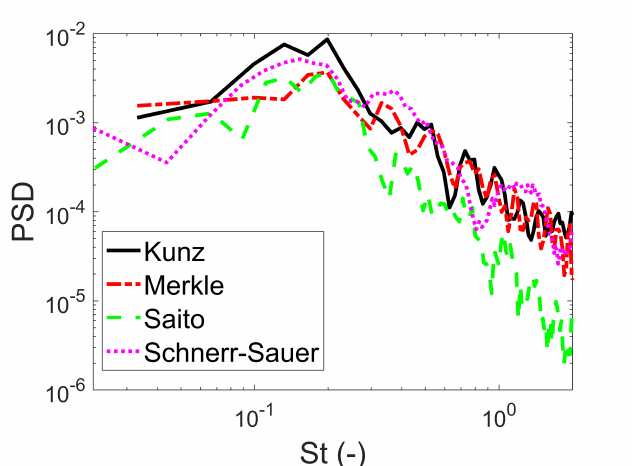
Figure 20. Lift coefficient spectrum with analytical-based coefficients.